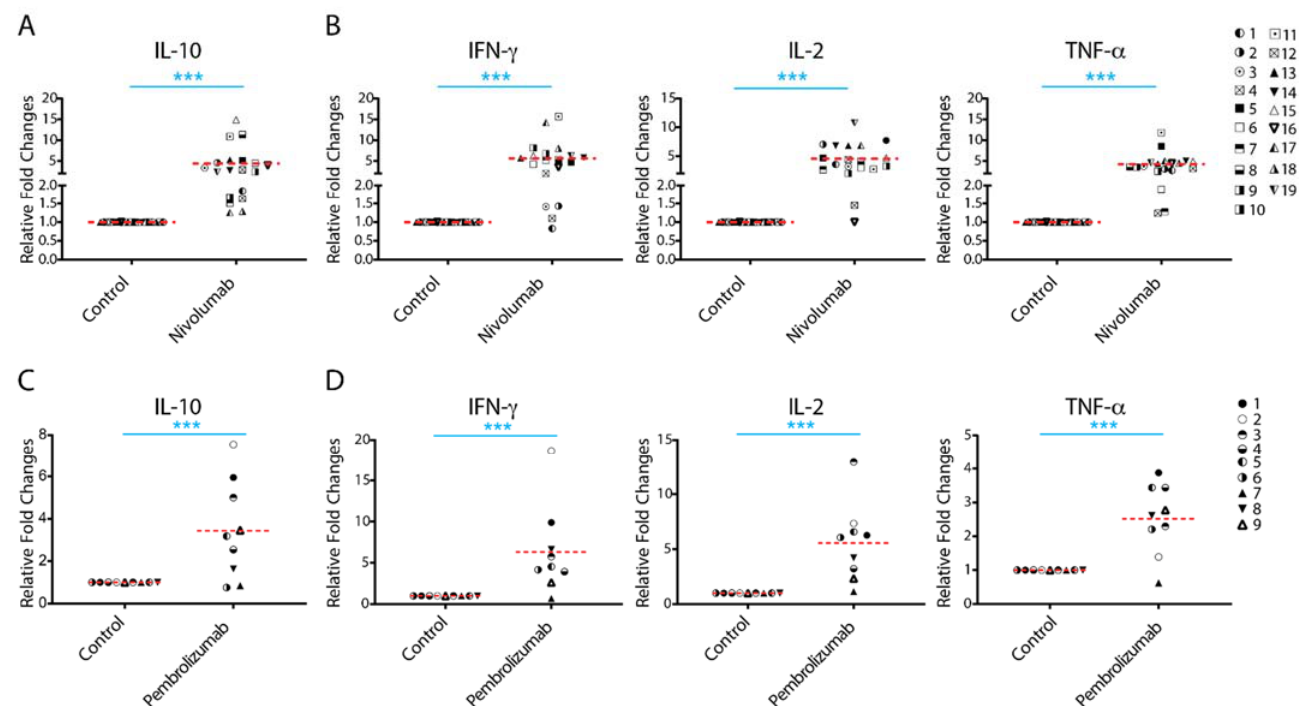
Figure 1. Treatment with nivolumab or pembrolizumab elicits potent interleukin ‐ 10 (IL ‐ 10) production from T cells. ( A , B ) Purified T cells were co ‐ cultured with allogeneic matured monocyte ‐ derived dendritic cells in the presence of nivolumab (20 μ g/mL) for 5 days, after which the culture media was harvested for multiplex analysis of production of IL ‐ 10 (A) , and interferon ‐γ (IFN ‐γ ), IL ‐ 2, and tumor necrosis factor ‐α (TNF ‐α ) ( B ). ( C , D ) Purified T cells were co ‐ cultured with allogeneic monocyte ‐ derived dendritic cells in the presence of pembrolizumab (20 μ g/mL) for 5 days, after which the culture media was harvested for multiplex analysis of the production of IL ‐ 10 ( C ) and IFN ‐γ , IL ‐ 2 and TNF ‐α ( D ). Graphs show the relative fold changes over the no ‐ antibody treatment controls. Each symbol represents data from one individual donor pair. Note: The representative symbols between Figure 1A, 1B (nivolumab treatment group) and Figure 1C, 1D (pembrolizumab treatment group) are not the same. Student’s t ‐ test, *** p < 0.001.